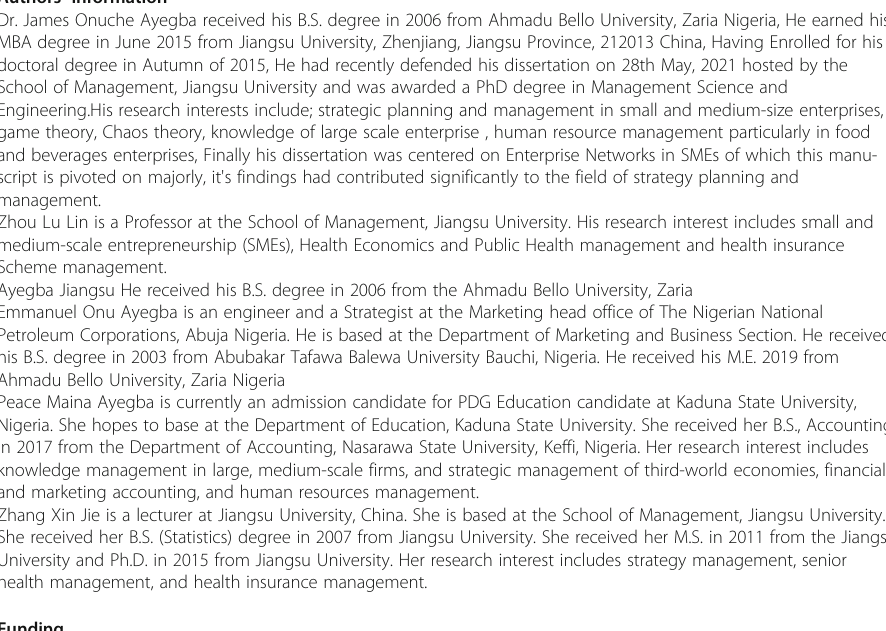
Abbreviations SEM: Structural equation modelling; ECOWAS: Economics Community of West African States; PLS: Partial least square; NSE: Nigerian Stock Exchange; WLSMV: Weighted least squares estimator; FGN: Federal Government of Nigeria; NEED S: National Economic Empowerment and Development Strategy; LRT: likelihood ratio test; SDM: Strategic decision- making; TC: Technological capability; SF: Strategic flexibility; CI: Competitive intensity; TT: Technological turbulence; RMSERA: Root mean square error of approximation indexes; LASU: Lagos State